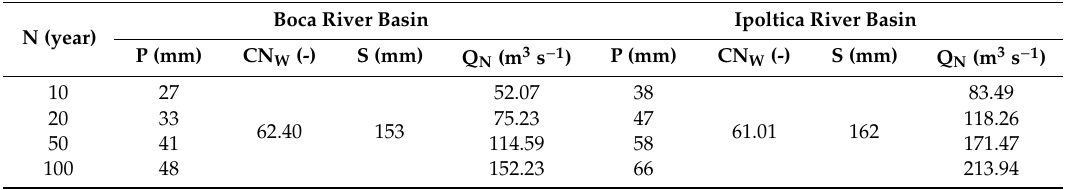
Table 12. Estimation of the design floods using the design values of the rainfall intensities from the future scenarios (N–return period; P–design values of short-term rainfall; CN w –weighted CN value; S–maximum potential retention; Q N –the design flood).